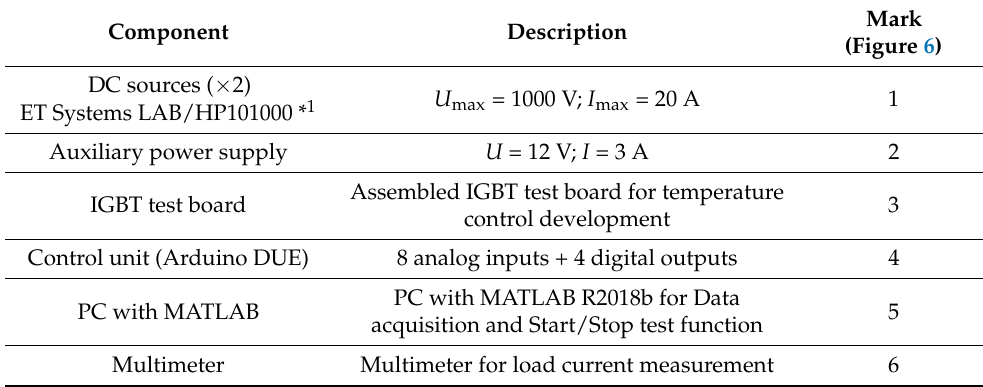
Table 2 lists the equipment used in the test setup. Table 2. Equipment used in the test